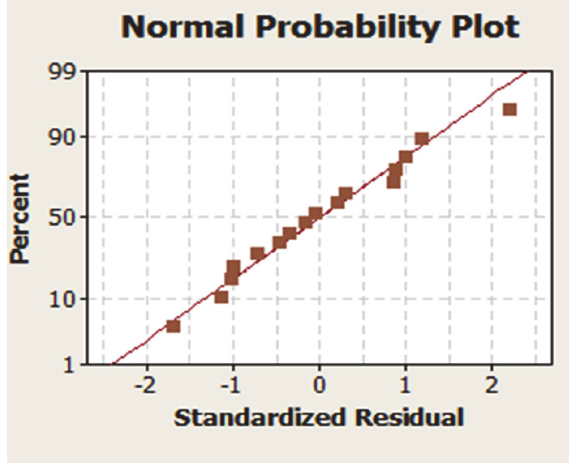
Fig. 8. Normal Probability plot obtained from the